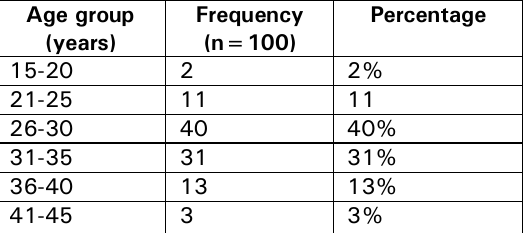
Table 1: Age Distribution